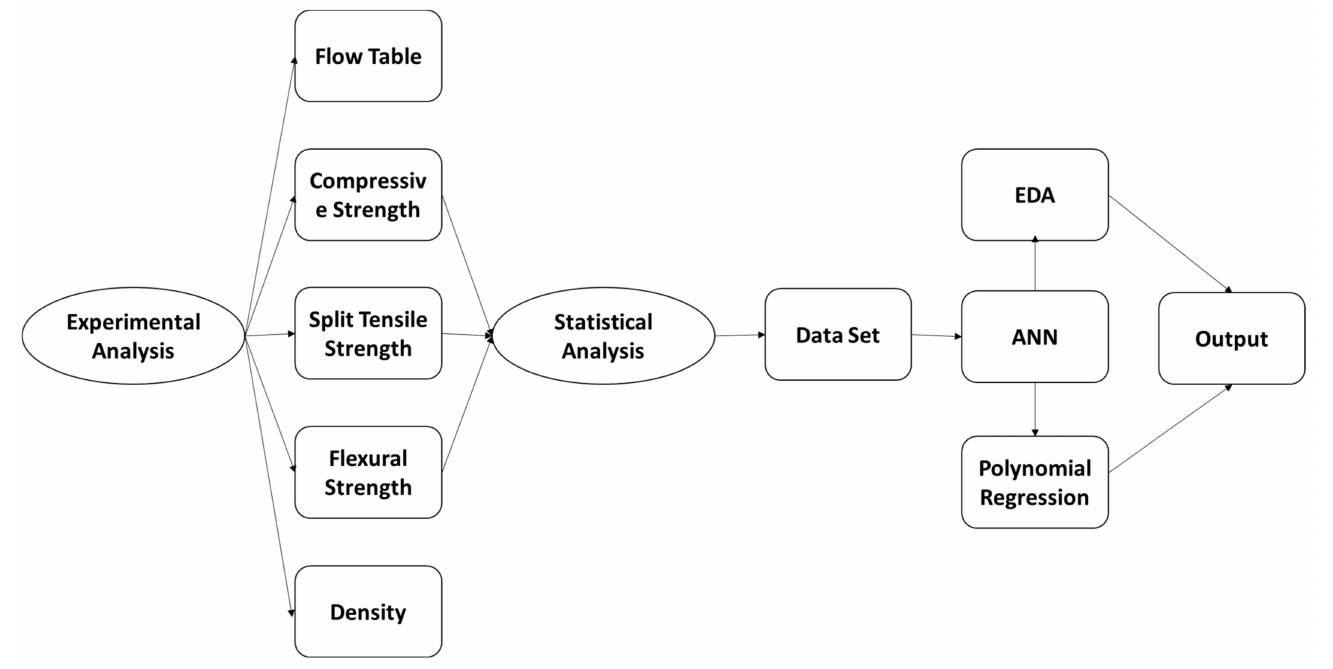
Figure 1. Flow Diagram of